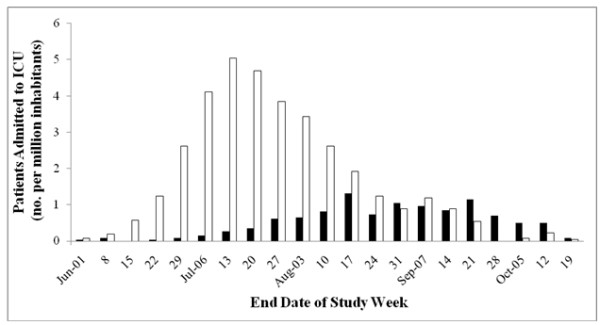
Number ICU admission with H1N1 2009 according to study week during 2009 (white bars) and 2010 (dark bars).